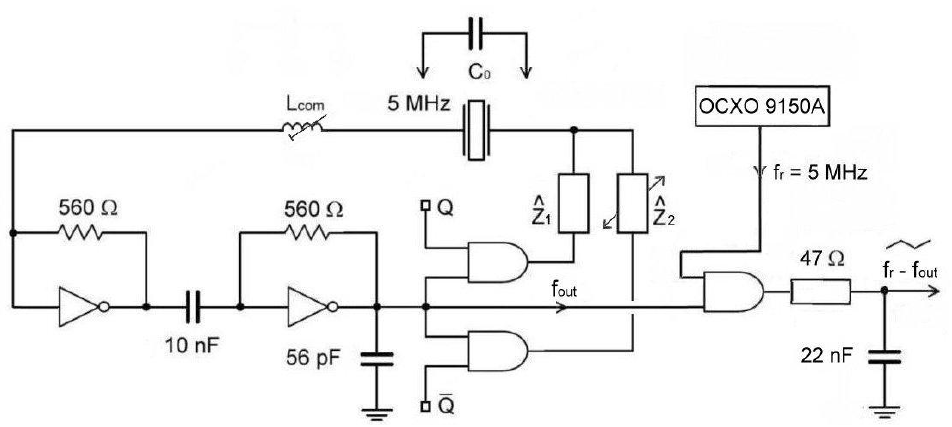
Figure 1. Quartz crystal switching